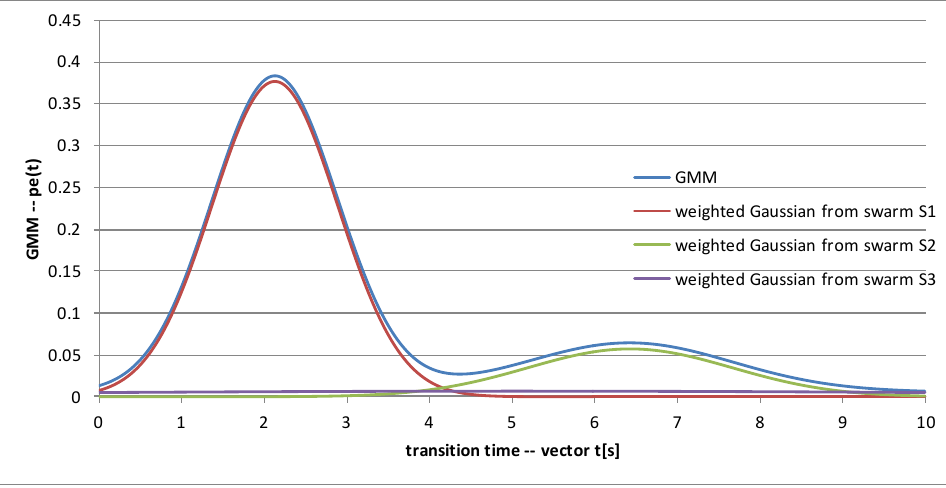
Figure 18. GMM obtained on the basis of swarms